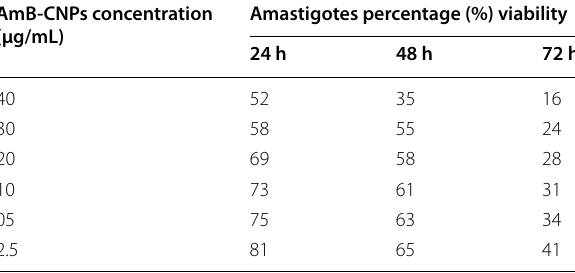
Data are expressed as mean Table 4 Amastigotes viability percentage after treatment with